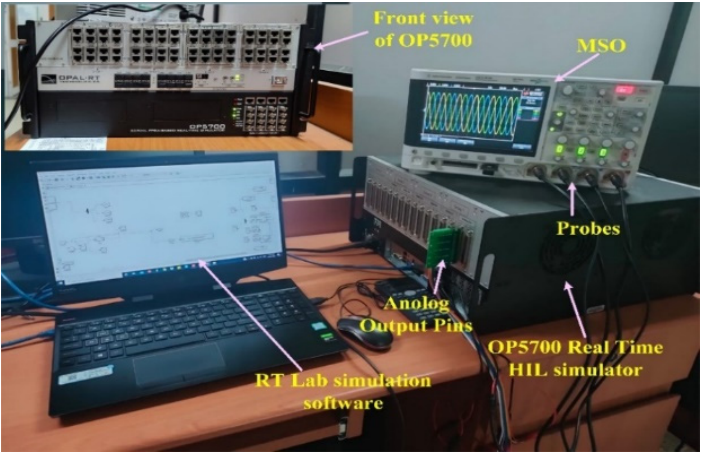
Figure 16. Real-time HIL setup. Table 3. MMC system parameter values.